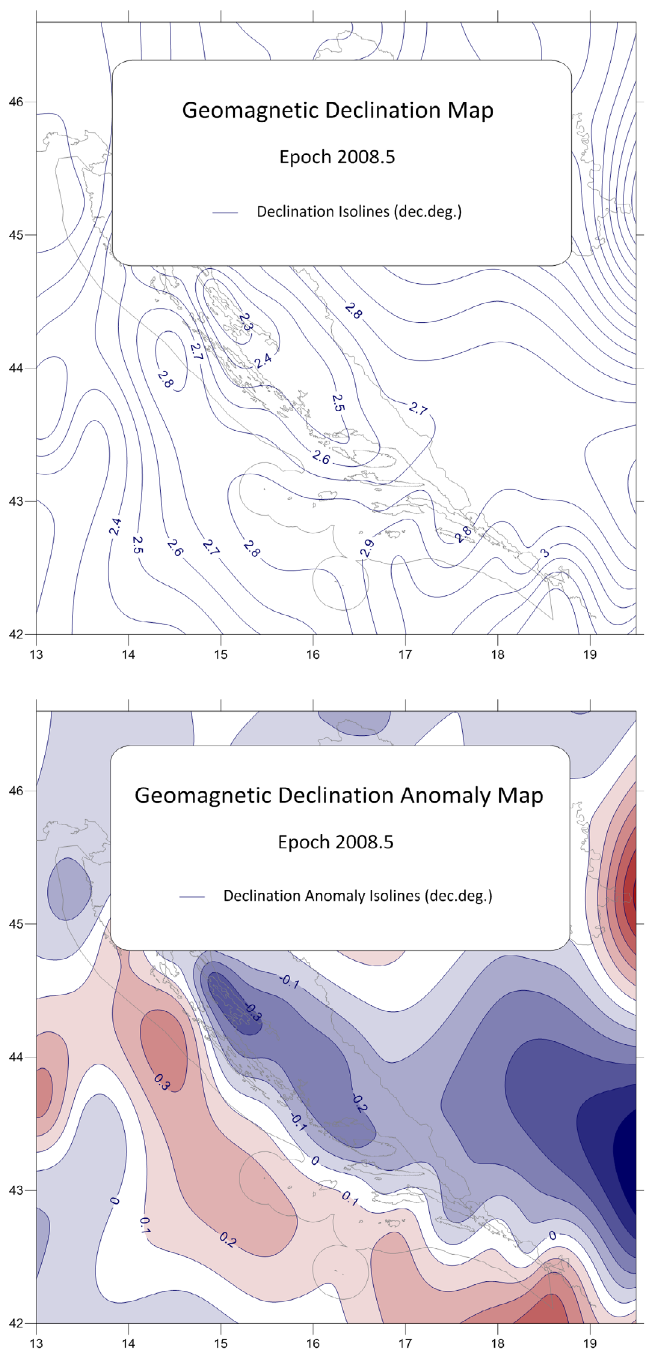
Figure 3. Declination and its anomaly at